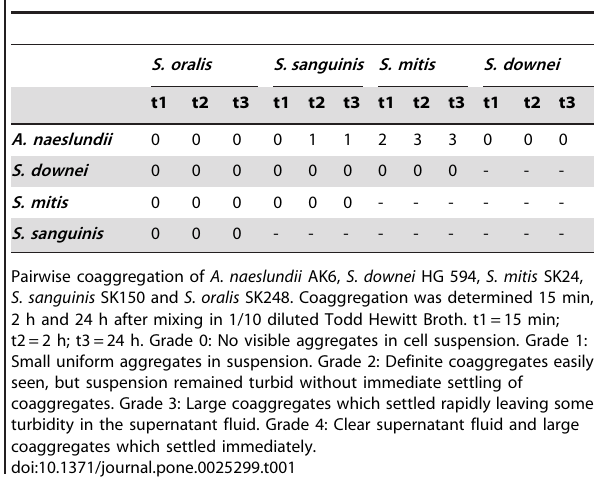
Table 1. Pairwise bacterial coaggregation.